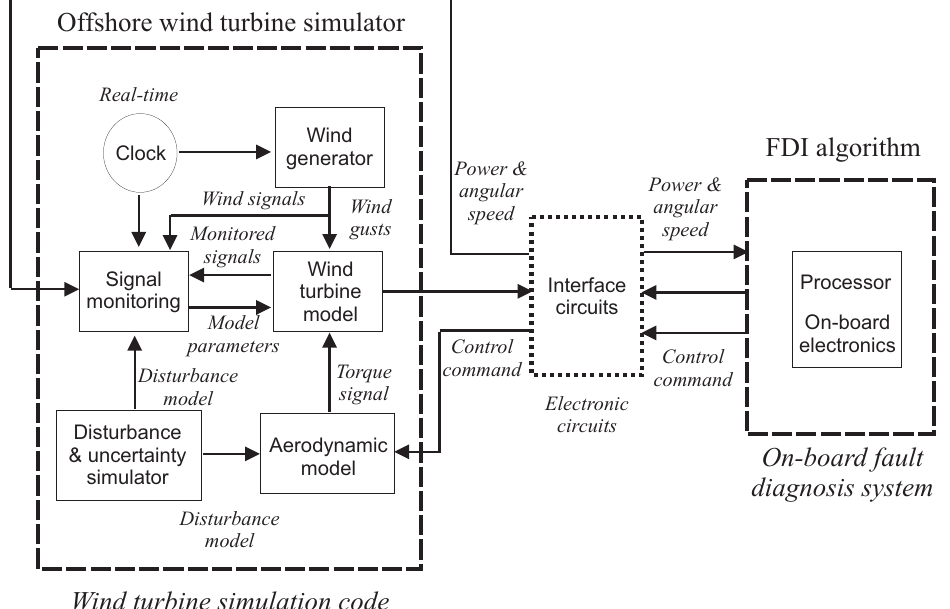
Figure 7. The block diagram of the HIL test rig. FDI, Fault Detection and